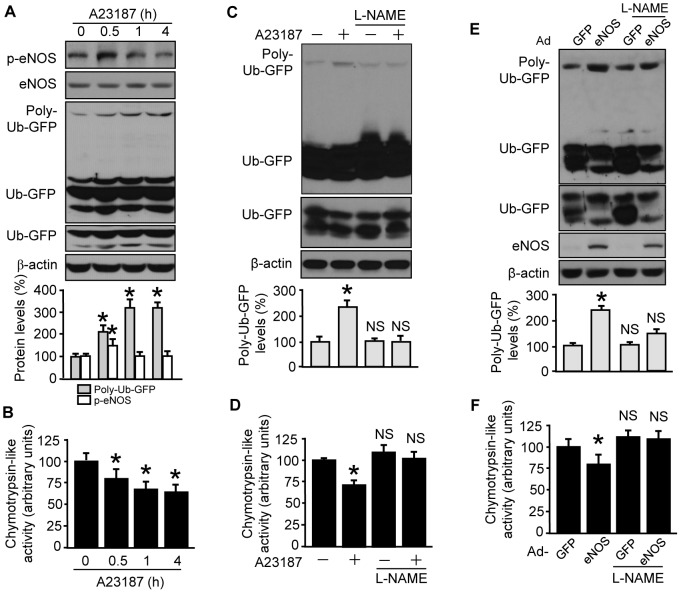
A23187 (eNOS activator) and overexpression of eNOS suppresses 26S proteasome functionality in vascular endothelial cells.The UbG76V-GFP-expressing HUVEC were incubated with (A) A23187 (1 µM) for indicated time up to 4 h and the 26S proteasome reporter protein poly-Ub-GFP was stained with a rabbit-derived anti-GFP antibody, total eNOS and p-eNOS (Ser 1177) was stained with respective antibodies through Western blot. (B) Assay of the chymotrypsin-like activity. (C) Preincubation of L-NAME (1 mM) abolished A23187 enhanced reporter protein accumulation. (D) The chymotrypsin-like activity. (E) Adenoviral overexpression eNOS increased the 26S proteasome reporter protein poly-Ub-GFP, which was prevented by preincubation of L-NAME (1 mM) for 1 h. (F) The chymotrypsin-like activity. The presented blots were representative of at least 3 independent experiments with similar results. * represent p<0.05 vs control or 0 h (n = 3). An overlaid portion (less exposure) of each whole blot indicating Ub-GFP is presented. Ad-, Adenoviral overexpression; NS, not significant (v.s. control); Ub-GFP, ubiquitin-green fluorescent protein; eNOS, endothelial nitric oxide synthase; L-NAME, L-NG-Nitroarginine methyl ester.